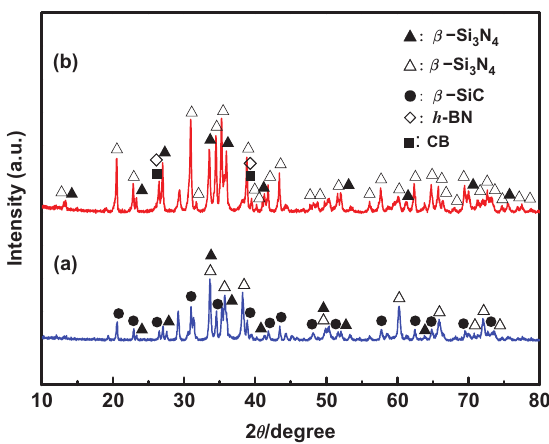
Figure 7. XRD of (a) Si 3 N 4 /CB composite ceramics; (b) Si 3 N 4 /BN(CB) composite ceramics.